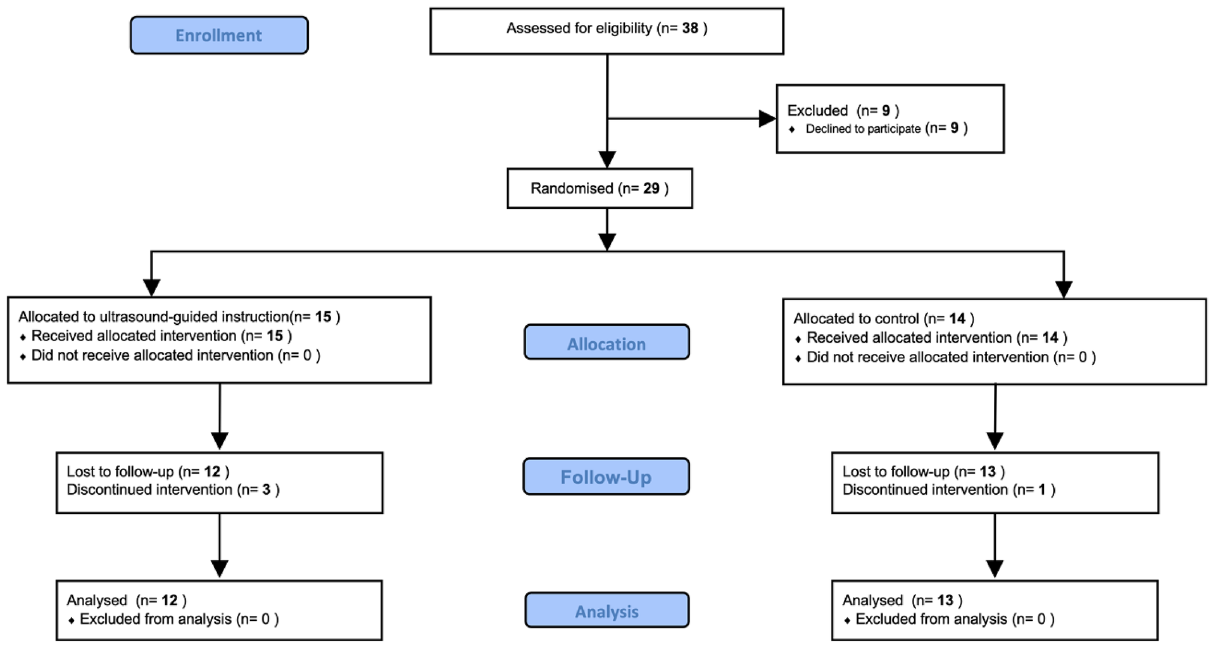
Figure 1. CONSORT flow diagram of the study.